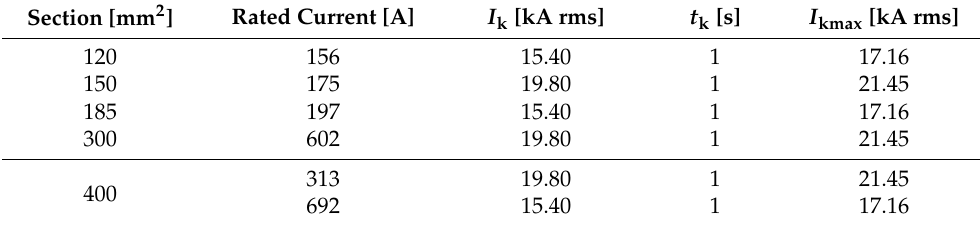
Table 14. Electrical data assumed for the 20-kV cables.